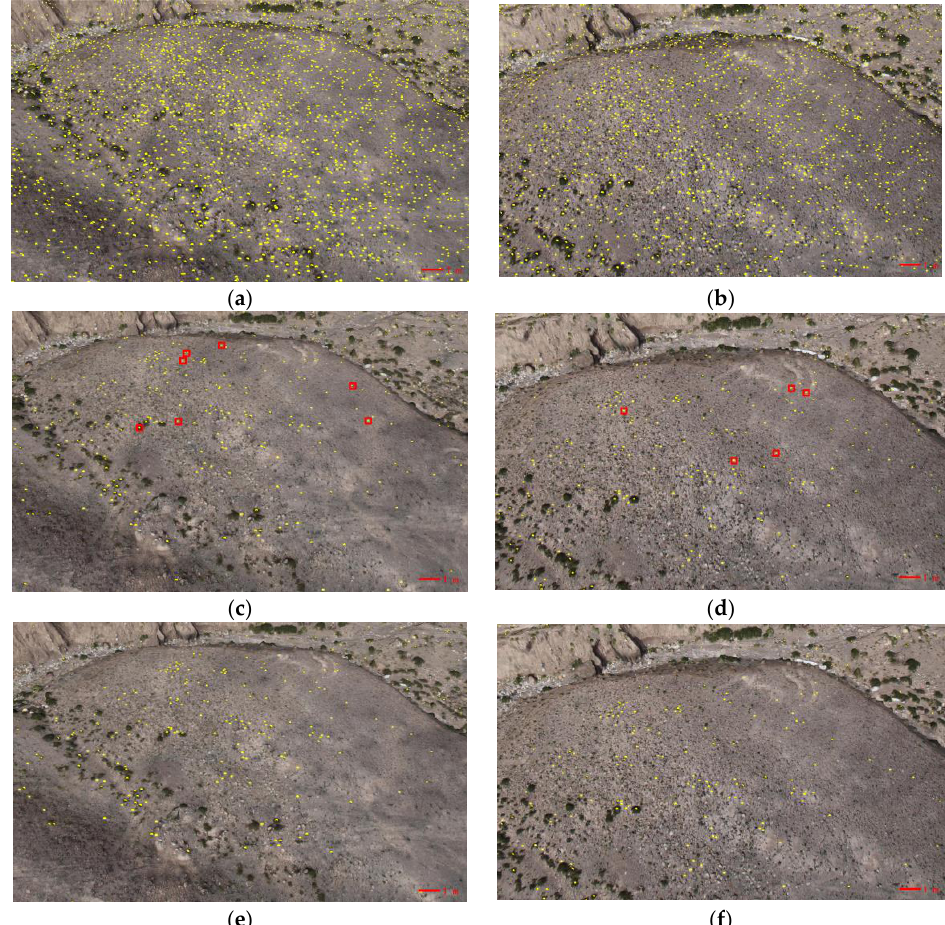
Figure 10. The corresponding distribution of spatial-feature points, the yellow dots in the figure are the spatial-feature points. ( a ) The initial spatial-feature points extracted. ( c ) The initial correspondence of spatial-feature points, with incorrect correspondence in the red box. ( e ) The fine correspondence of spatial-feature points after registration. ( b , d , f ) corresponds to ( a , c , e ) and are the results of the second-cycle data. The yellow dots in Figure 10a,b represent the distribution of spatial-feature points